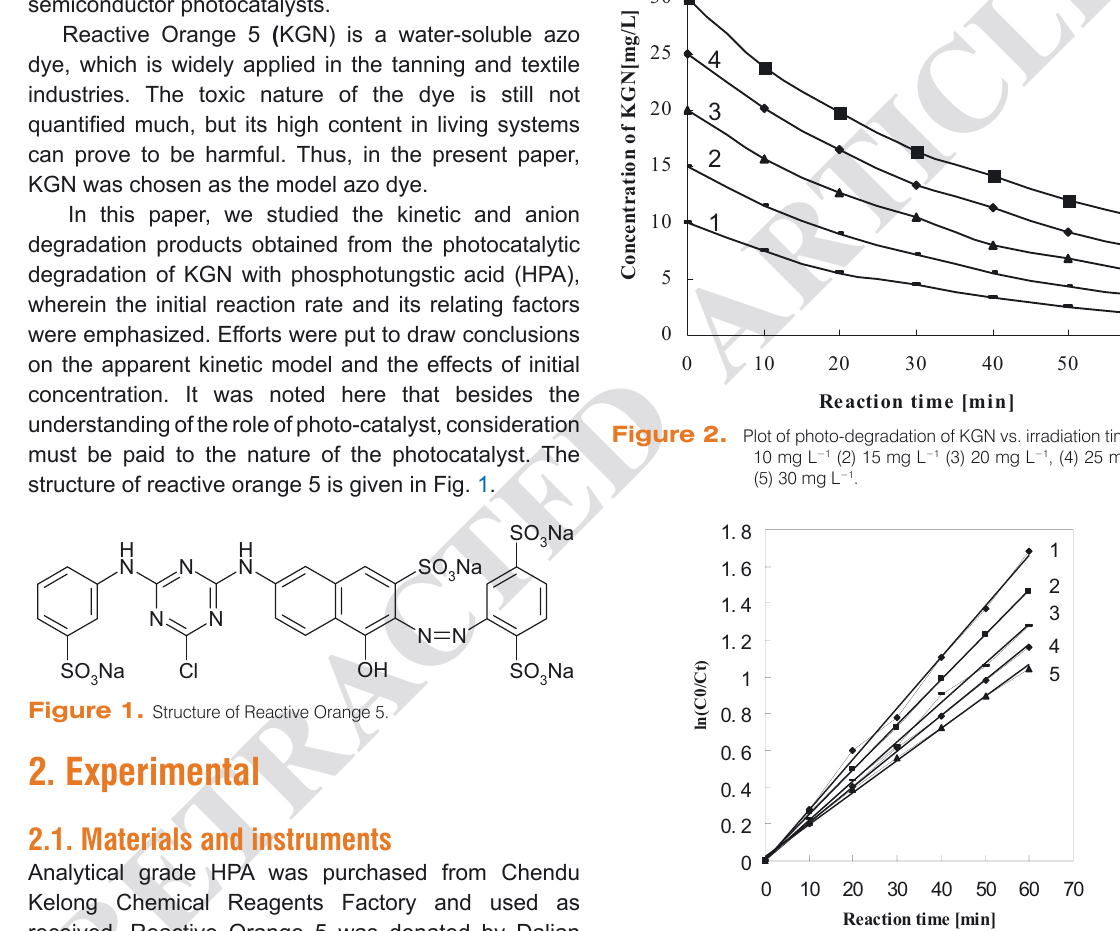
Figure 3. ln(C /Ct) vs. illumination time (1) 10 mg L −1 (2) 15 mg L −1 0 (3) 20 mg L −1 (4) 25 mg L −1 (5) 30 mg L −1 .